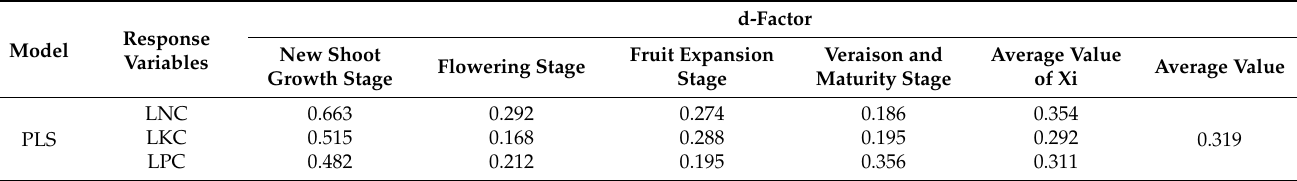
Table 8. Uncertainty measurement parameter (d-factor) for different